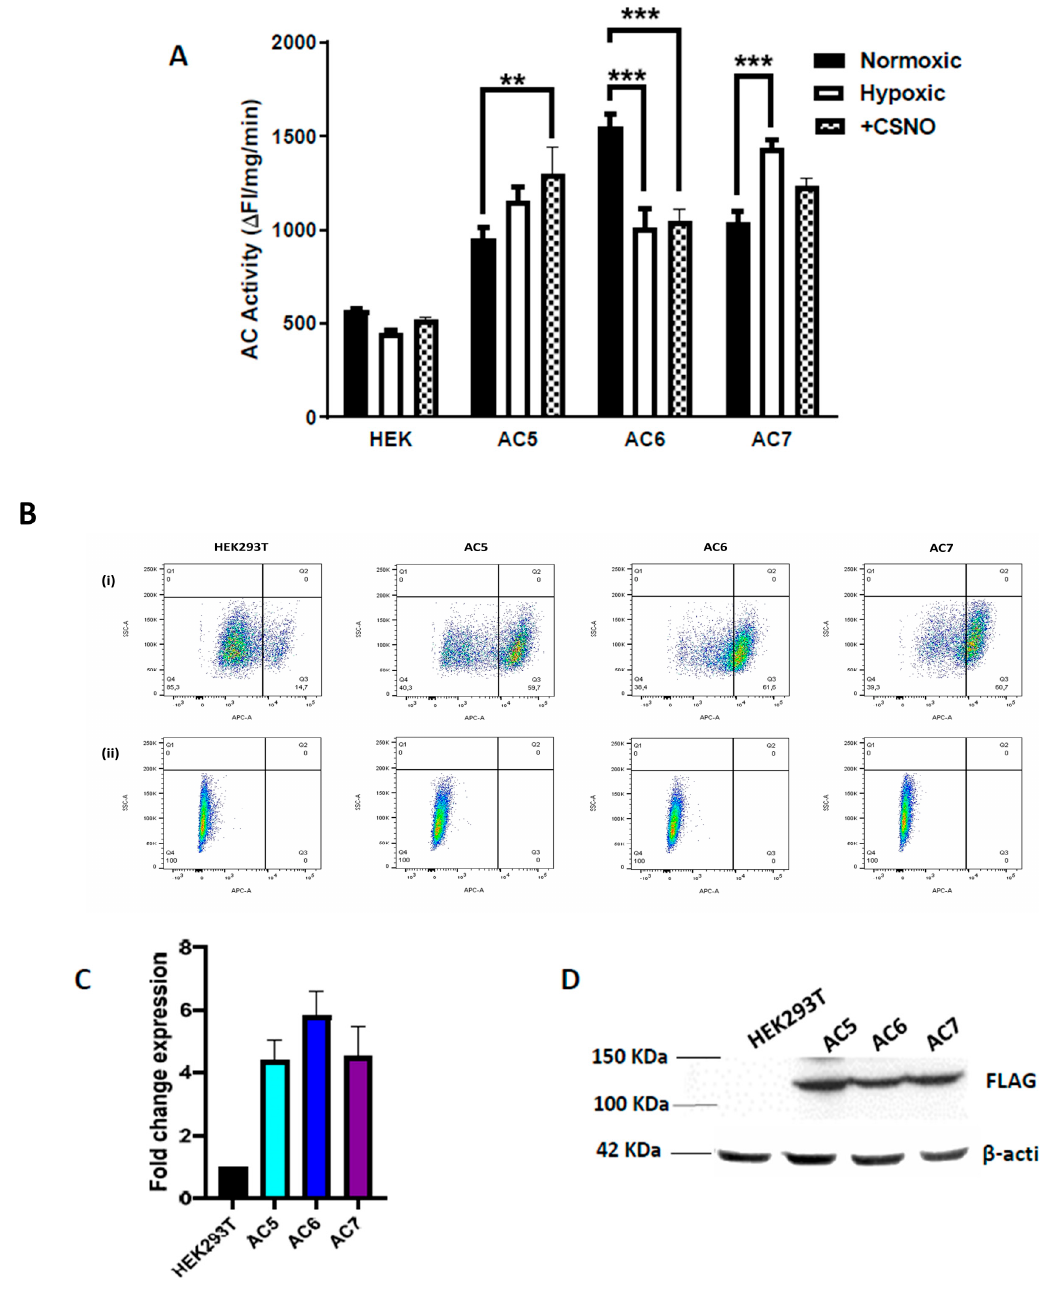
Figure 1. AC activity in naïve HEK293T cells and AC isoforms 5, 6 or 7 stably overexpressed in HEK293T, exposed to ( A ) 72 h hypoxia (10% O 2 , 5% CO 2 ) or 30 min 250 μ M nitrosocysteine (CSNO) treatment. Only isoform AC6 is inhibited by hypoxia and by CSNO treatment. N = 3, analysis by two-way ANOVA, ** p < 0.01, *** p < 0.001. ( B ) Expression of AC isoforms 5, 6, and 7 quantified by flow cytometry of cells fixed with 4% paraformaldehyde and permeabilized with 1% saponin in FACS buffer, using ( i ) APC-conjugated mouse monoclonal anti-FLAG (DYKDDDDK) antibody